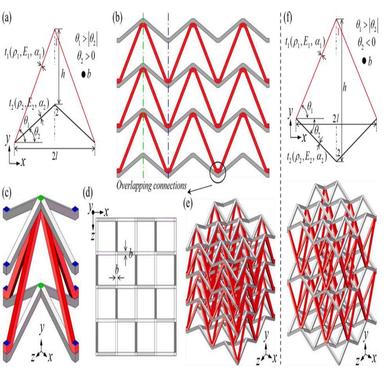
3D double-V hierarchical structures, (a) unit cell and geometry parameters of concave 2D double-V structure with θ2 > 0, in-plane thickness t1, density ρ1, Young's modulus E1 and CTE α1 for V1 marked in red color and t2, ρ2, E2, and α2 for V2 marked in black color, (b) 2D double-V honeycomb structure with peak and valley symmetry axes marked in green and blue colors, (c) construction of 3D double-V hierarchical structures by combining 2D double-V components through the symmetry axes. (d) The top view of cor